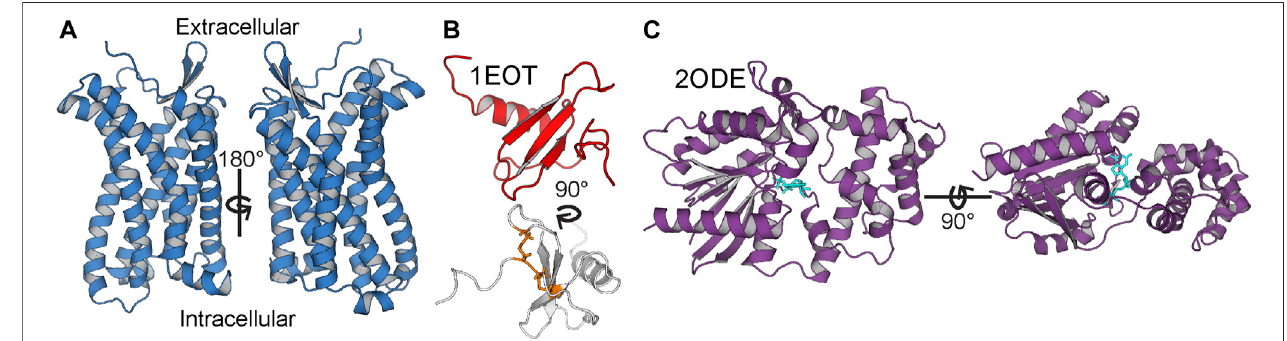
FIGURE 2 | Anatomy of CCR3, CCL11, and G α i 3. (A) CCR3 homology model is marked by the canonical seven-transmembrane helical architecture. (B) Solution stateNMRstructureofCCL11(PDBID1EOT)(Crumpetal.,1998)showsthestructuraldisul fi debondsinorange(bottom). (C) G α i 3(purple)withboundGDP(cyan)from the crystal structure of G α i 3 bound to the regulator of G protein signaling 8, RGS8 (PDB ID 2ODE) (Soundararajan et al.,